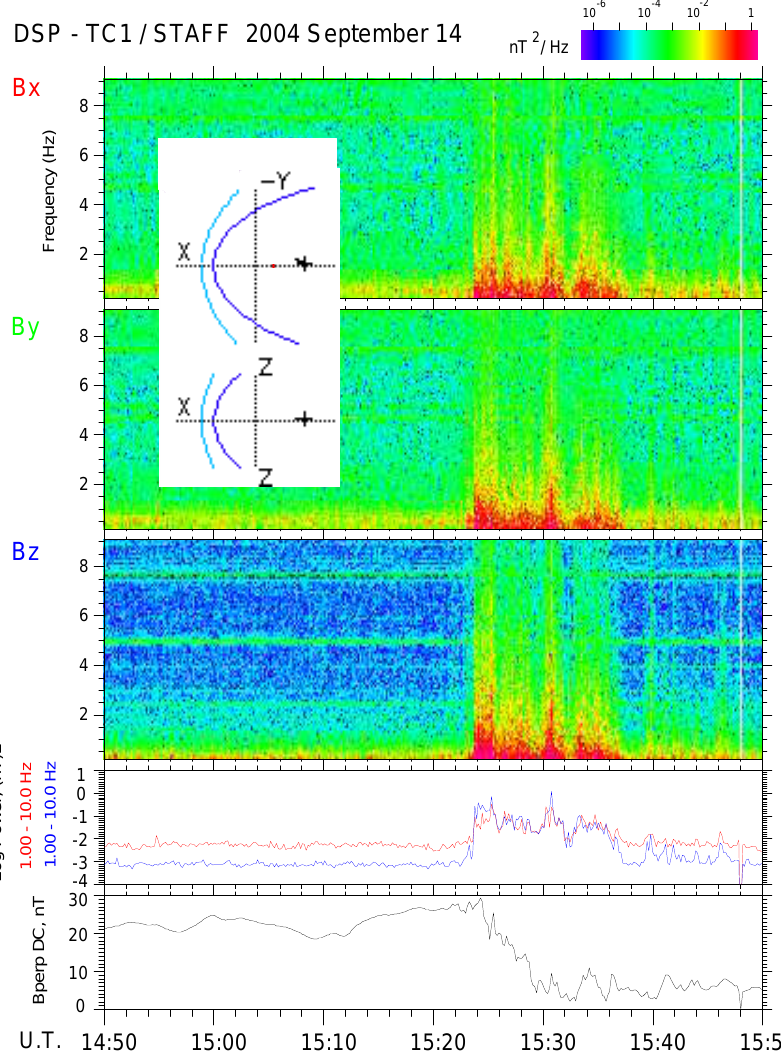
Fig. 12. DSP STAFF wave form data for an event in the tail on 14 September 2004. The start of ULF turbulence corresponds to a substorm. From top to bottom are plotted the 3 components of the dynamic spectra, the integrated power for B x (in red) and B z (in blue) and below the modulus of the magnetic field in the spin plane as inferred from the STAFF spin signal. The data are very clean, as DSP is in an eclipse for that time